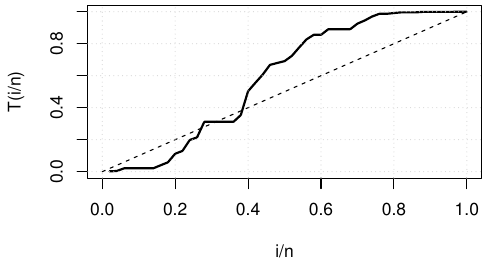
Figure 11. TTT plots for the lifetimes for real data I. Table 3. Maximum likelihood estimates, L, AIC, CAIC, BIC, KS ( p -value) for real data I. Distributions